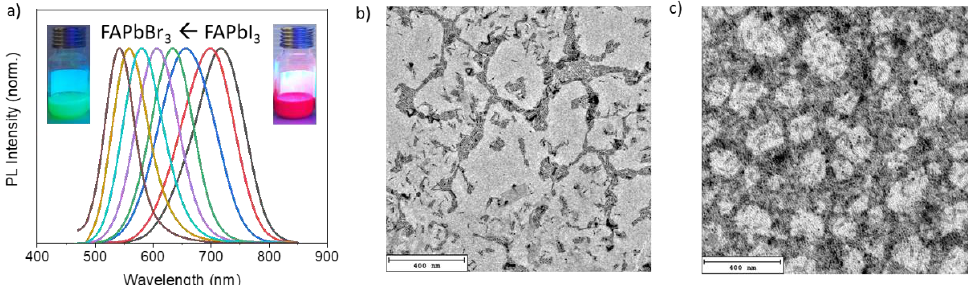
Figure 2. PL spectra of FAPbX 3 (X = Br, and I) NRs after halide-exchange reactions performed on the